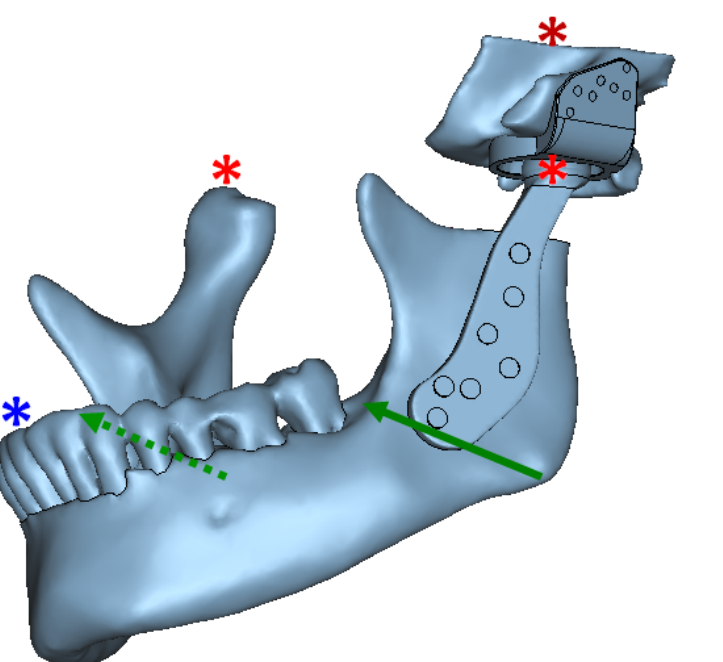
Figure 28. Assembly of all parts of the FE model (including anatomic and prosthetic components), and schematic representation of model constraints and load application for FE simulation of total TMJ prostheses and anatomical components. Green arrows depict the location and direction of bite forces applied in the angulus region on both sides of the mandibular mesh. The asterisks indicate constrained nodes at condyle, fossa, and incisor teeth. Left prosthetic condylar head and right natural condylar head were constrained such that they could only rotate along the medio–lateral axis and translate in anterior-posterior direction. The nodes at incisor teeth were so constrained such that they could only rotate. The entire fossa host bone was constrained in all directions. The interface between prosthetic condylar head and articulating surface of prosthetic fossa was modeled as sliding contact. The prosthesis-to-bone, screw-to-prosthesis, and screw-to-bone interfaces were assumed to be bonded. The interfacial and boundary conditions were kept similar for normal and over–load configurations; and only magnitude of applied forces was changed across the two loading